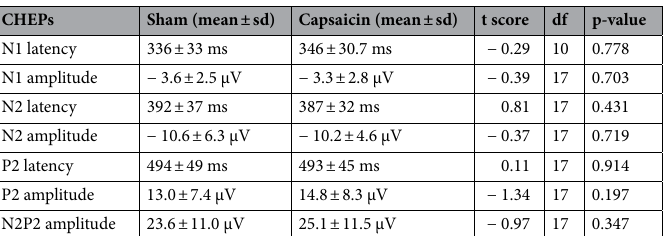
Table 3. CHEPS sham and capsaicin comparison. CHEPs: contact heat evoked potentials; df: degree of freedom; sd: standard